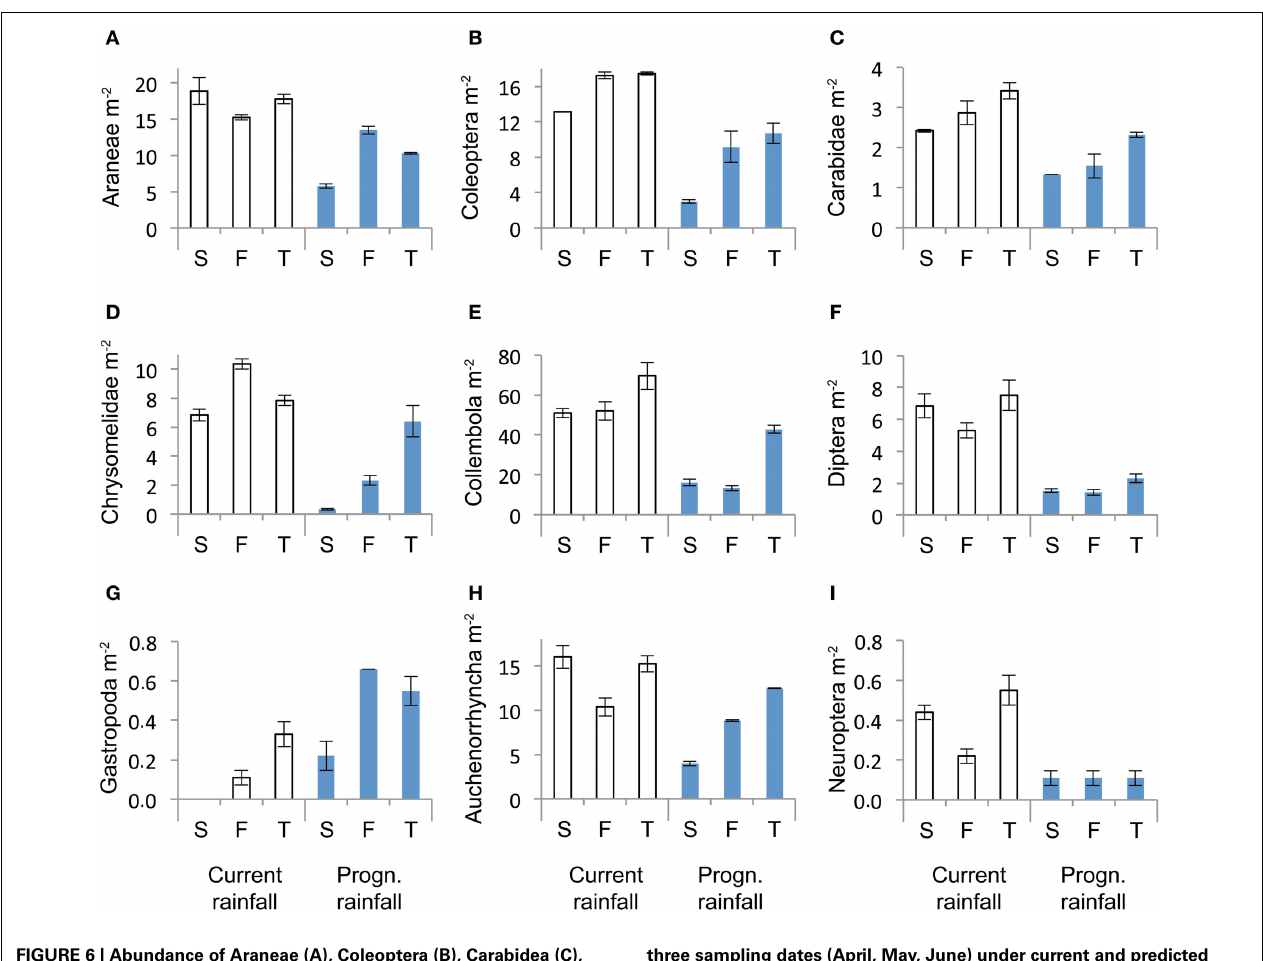
three sampling dates (April, May, June) under current and predicted rainfall at the soil types calcaric phaeozem (S), gleyic phaeozem (F) and calcic chernozem (T). Means ± SE, n =